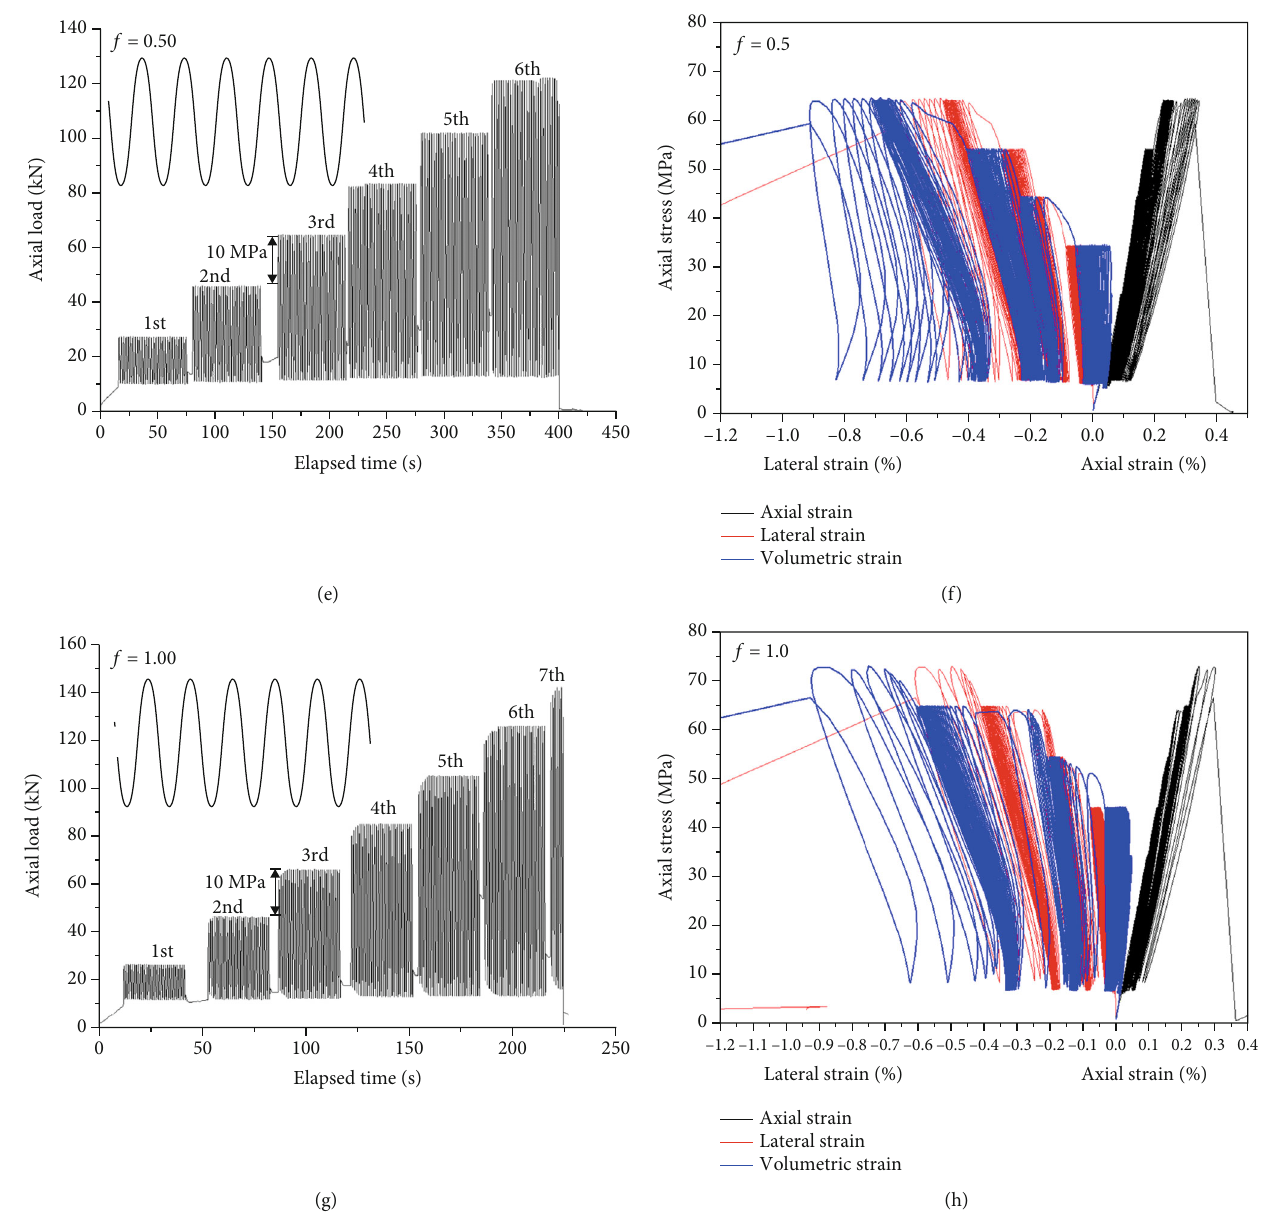
Figure 3: The loading path and the corresponding complete stress-strain curves for the typical granite samples under dynamic frequency of 0.04, 0.1, 0.5, and 1.0, respectively. (a, c, e, g) Plots of the loading path of the cyclic loading. (b, d, f, g) Plots of the axial, lateral, and volumetric stress-strain